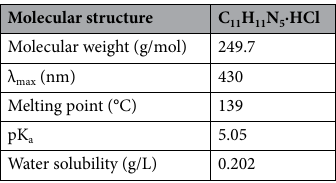
Table 1. Characteristics of phenazopyridine